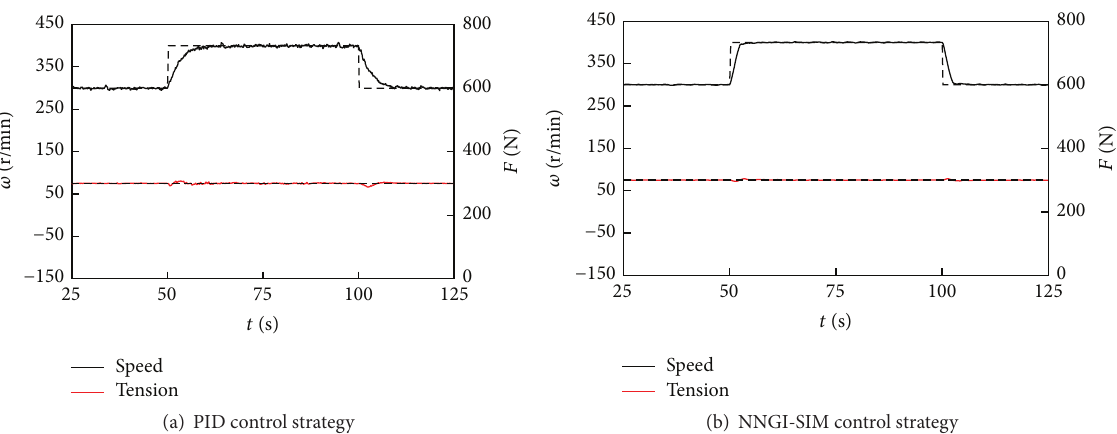
Figure 11: Experimental results when 𝜔 𝑟1 suddenly changes.